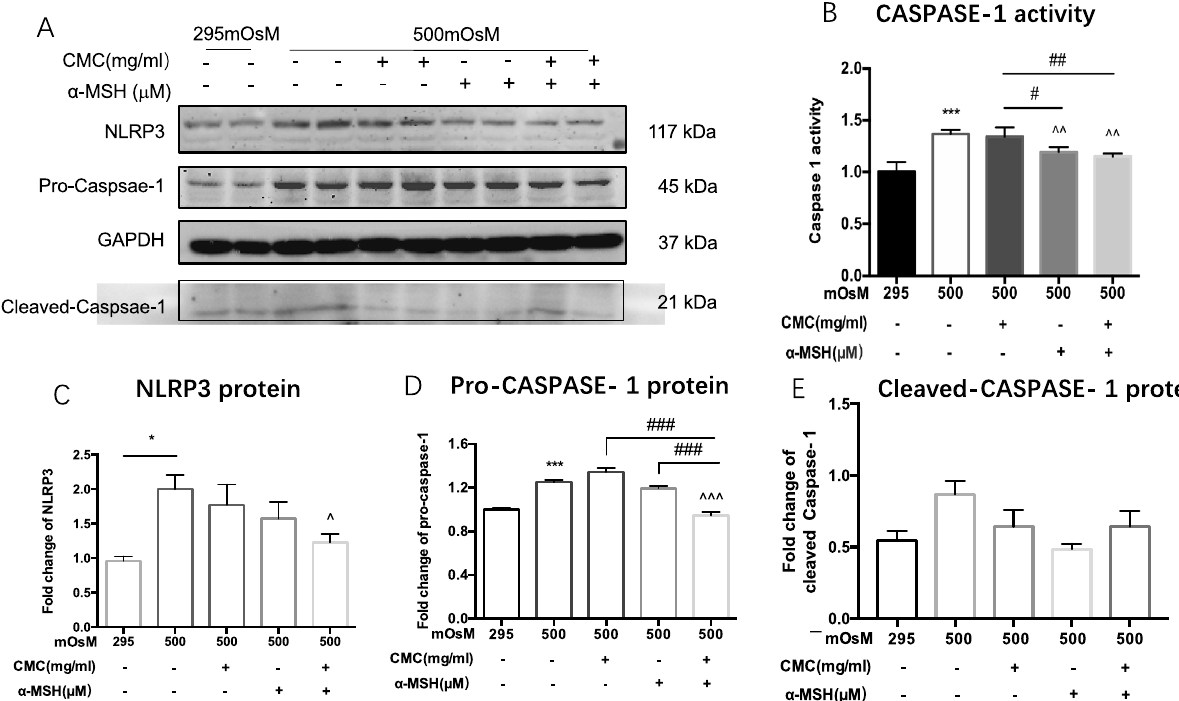
Figure 7. Combined CMC + α-MSH treatment reduced the ROS level and NLRP3 expression in HCECs exposed to hyperosmotic environmental stress. ( A – C ) Western blot analysis of cell lysates derived from HCECs among the indicated groups (n = 6). ( D , E ) Caspase-1 activities were compared among groups (n = 6). Data are shown as mean ± SEM. Three independent experiments were performed. The samples derive from the same experiment and that gels/blots were processed in parallel. ( A ) Showed the cropped gels and blots and full-length blots are presented in Supplementary Fig. S7A. *, # p < 0.05; **, ## p < 0.01; ***, ### p <